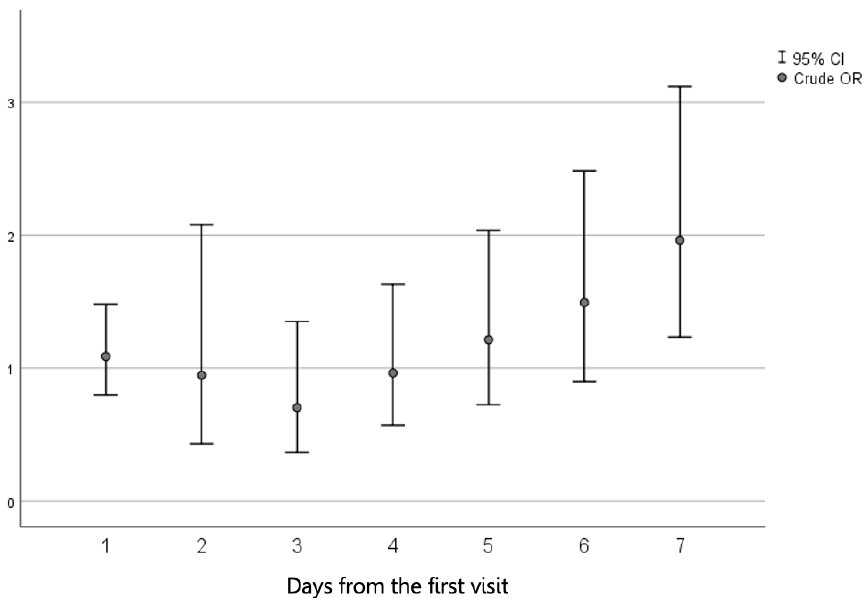
Figure 2. Crude odds ratio (OR) and 95% confidence interval (95% CI) of the association between the time (in days) between the first visit and the initiation of antibiotic treatment for shigellosis and ADHD rates as compared to no antibiotic treatment.